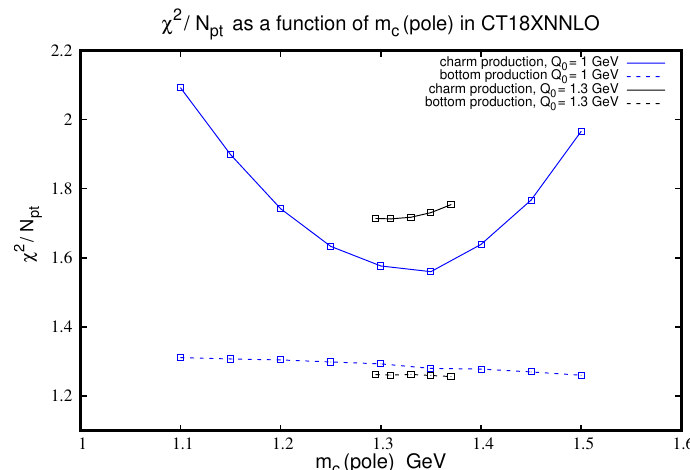
Figure 1: χ 2 / N for charm (solid) and bottom (dashed) production in the pt CT18XNNLO fit as a function of the charm-quark mass m ues of the input scale Q 0